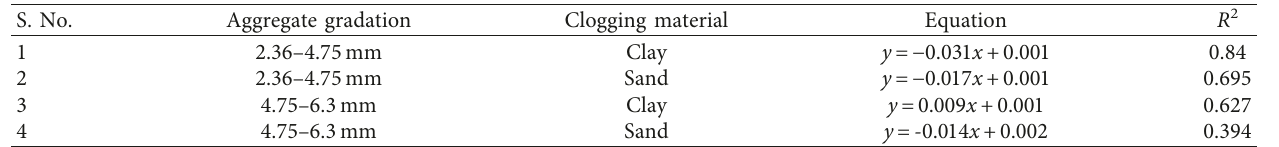
Figure 11: Clogging potential for all case scenarios. Table 7: Clogging potential